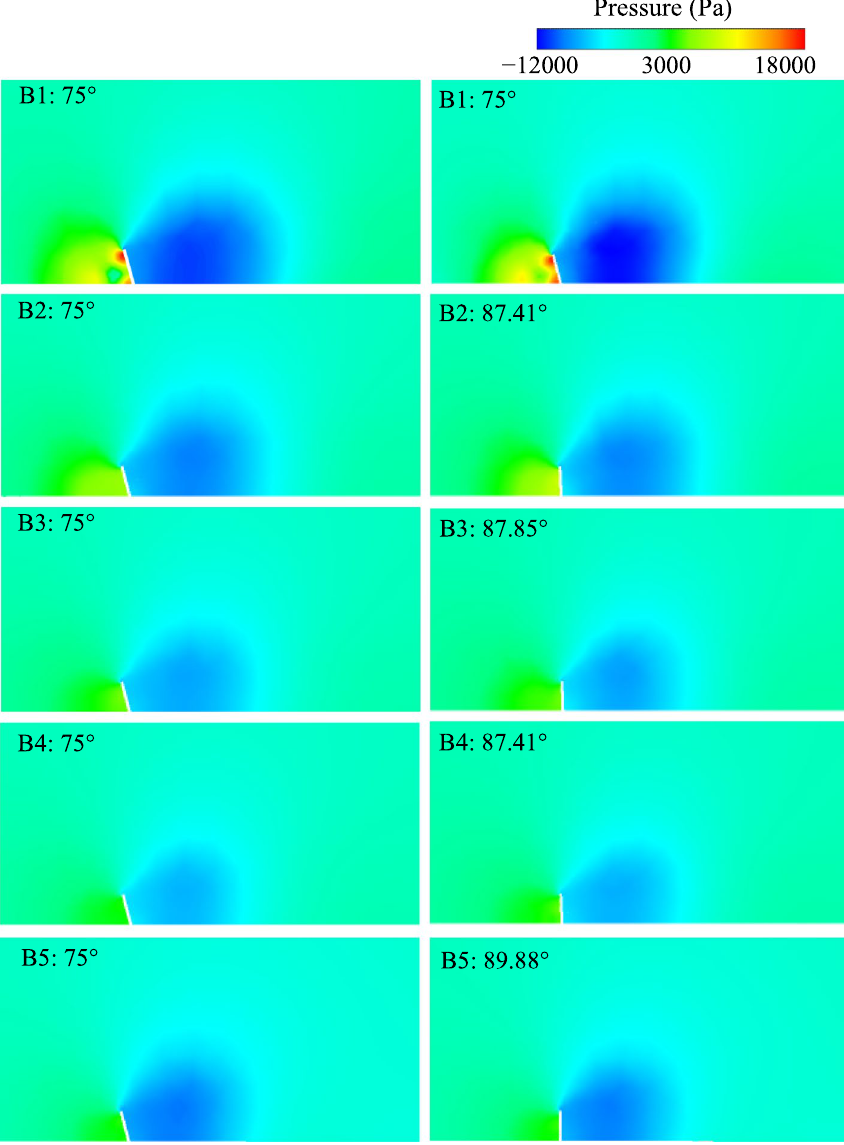
Fig. 17 The pressure distribution of braking plates pre and post